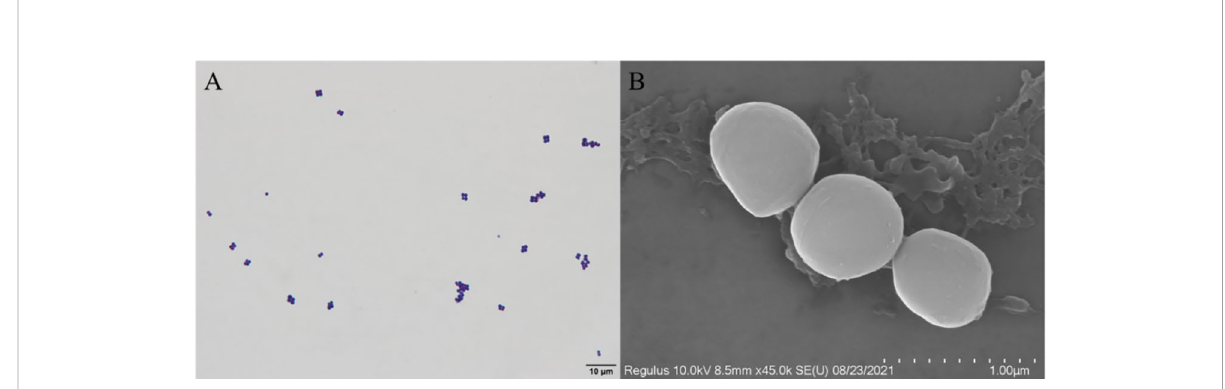
FIGURE 2 Morphological characteristics of strain D-59: (A) Gram stain (scale bar 10 m m); (B) Scanning electron microscopy (scale bar 1.00 m